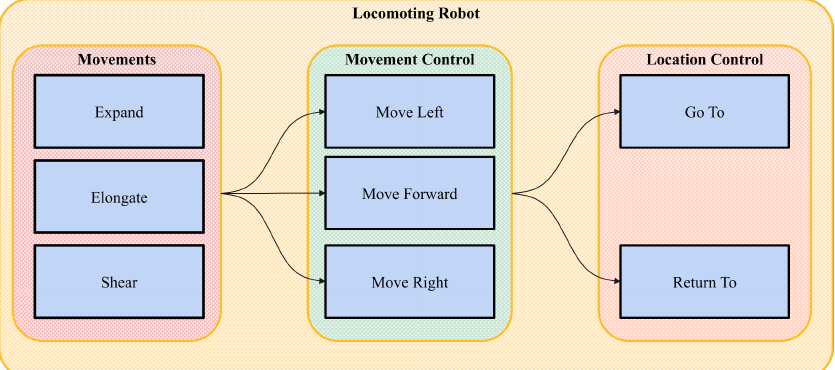
Figure 3. Framing the development of a locomoting robot using ESP. The high-level encapsulation defines the locomoting robot’s properties, while lower-level encapsulations such as “expand” are grouped within a given syllabus. Arrows indicate where lower-level encapsulations are used as elements in higher-level